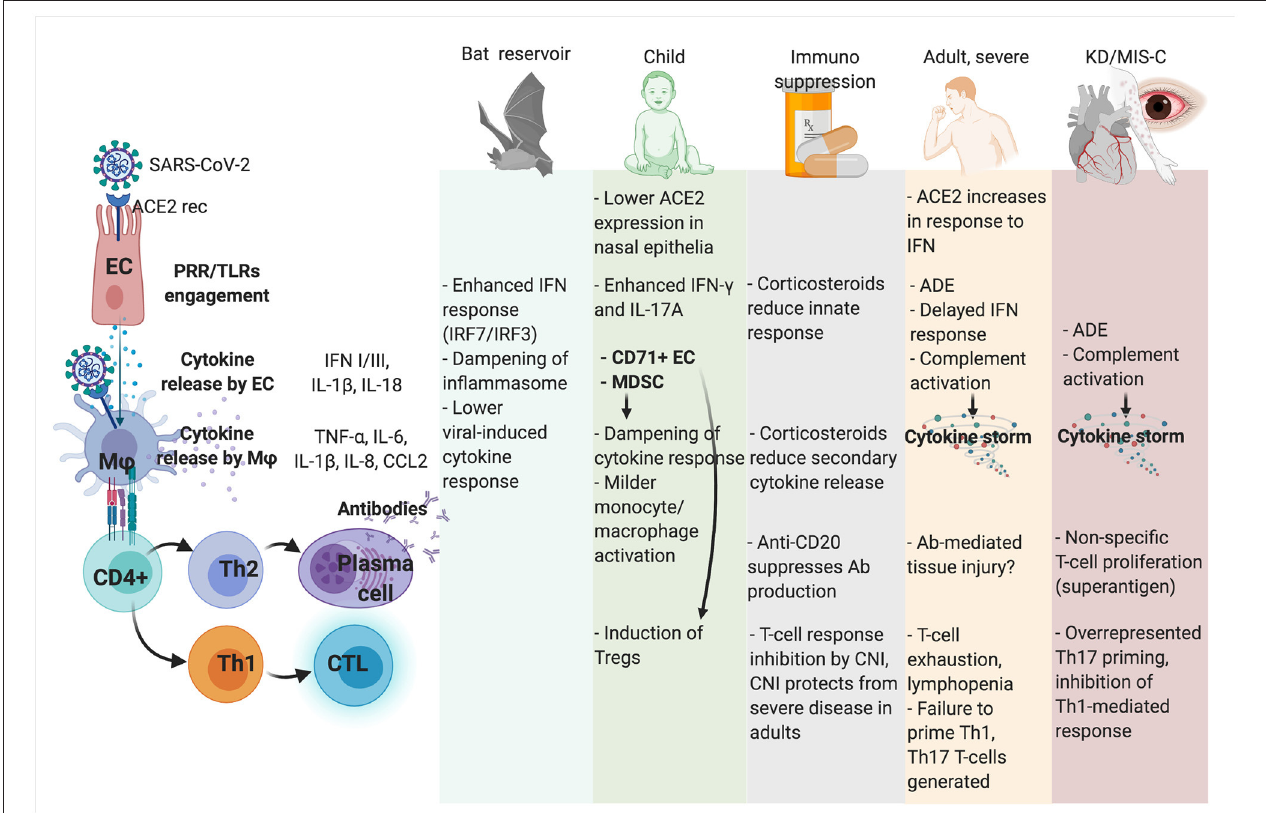
FIGURE 1 | Mechanism of immune competence, tolerance, and immunopathology toward SARS-CoV-2 infection in different hosts and clinical scenarios. ADE, antibody-dependent enhancement; CNI, calcineurin inhibitors; CTL, cytotoxic T cell; CD71 + EC, CD71 + erythroid precursors; EC, lung epithelial cell; KD, Kawasaki disease; MDSC, myeloid-derived suppressor cells; M φ , macrophage; MIS-C, Multisystem Inflammatory Syndrome in Children; PRR, Pattern Recognition Receptor; TLR, Toll-like receptors.